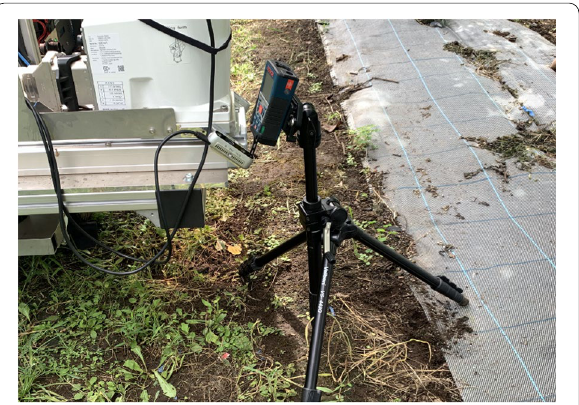
Fig. 15 Placement of the laser measure to measure the distance between the fruits and camera